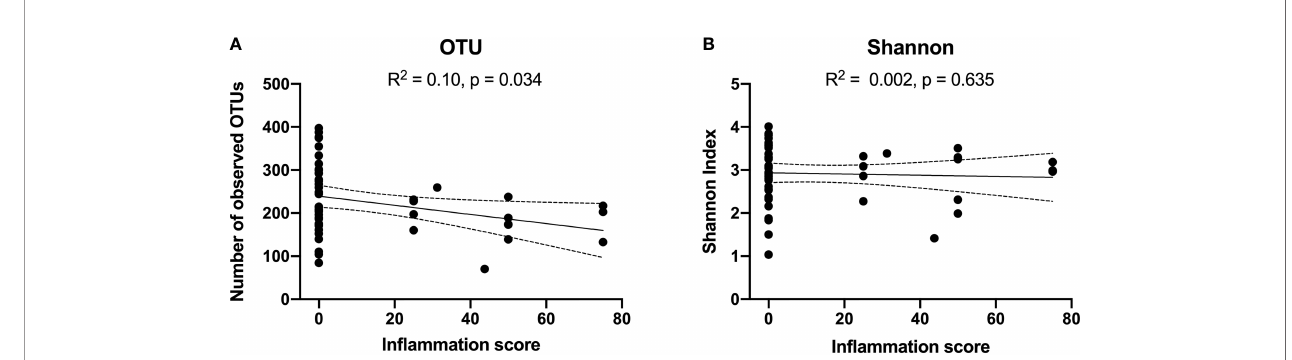
FIGURE 2 | Correlations between alpha diversity [OTUs in Panel (A) , and Shannon Index in Panel (B) ] and Cicatrising Conjunctivitis Clinical Assessment Tool (CCAT) score of bulbar conjunctival hyperaemia de fi ned as ‘ in fl ammation ’ in the worse eye. A higher clinical in fl ammation score represents a more active clinical disease. Reduced number of observed OTUs were correlated with extent of bulbar conjunctival in fl ammation (R2: 0.1, p= 0.03). However, there was no signi fi cant correlation between Shannon Index and in fl ammation. OTUs, operational taxonomic units.